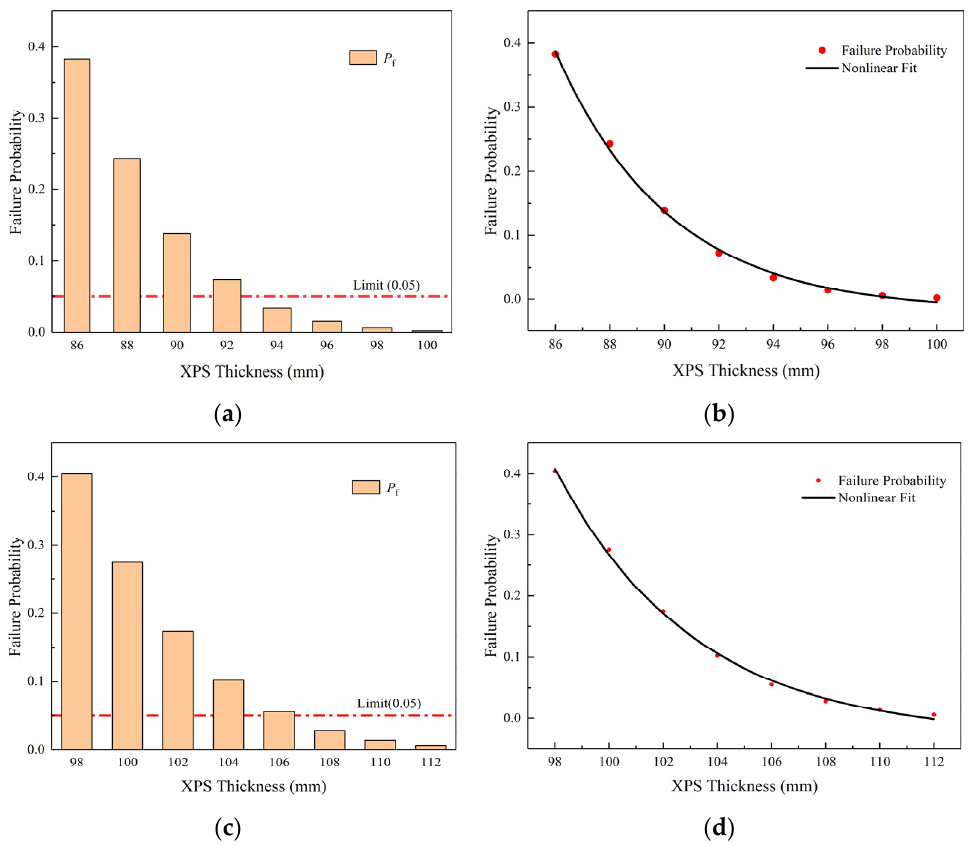
Figure 26. XPS thickness–failure probability: ( a ) results ( 𝐾 (cid:2922)(cid:2919)(cid:2923) = 0.58 ); ( b ) fitting the exponential function ( 𝐾 (cid:2922)(cid:2919)(cid:2923) = 0.58 ); ( c ) results ( 𝐾 (cid:2922)(cid:2919)(cid:2923) = 0.52 ); ( d ) fitting the exponential function ( 𝐾 (cid:2922)(cid:2919)(cid:2923) = 0.52